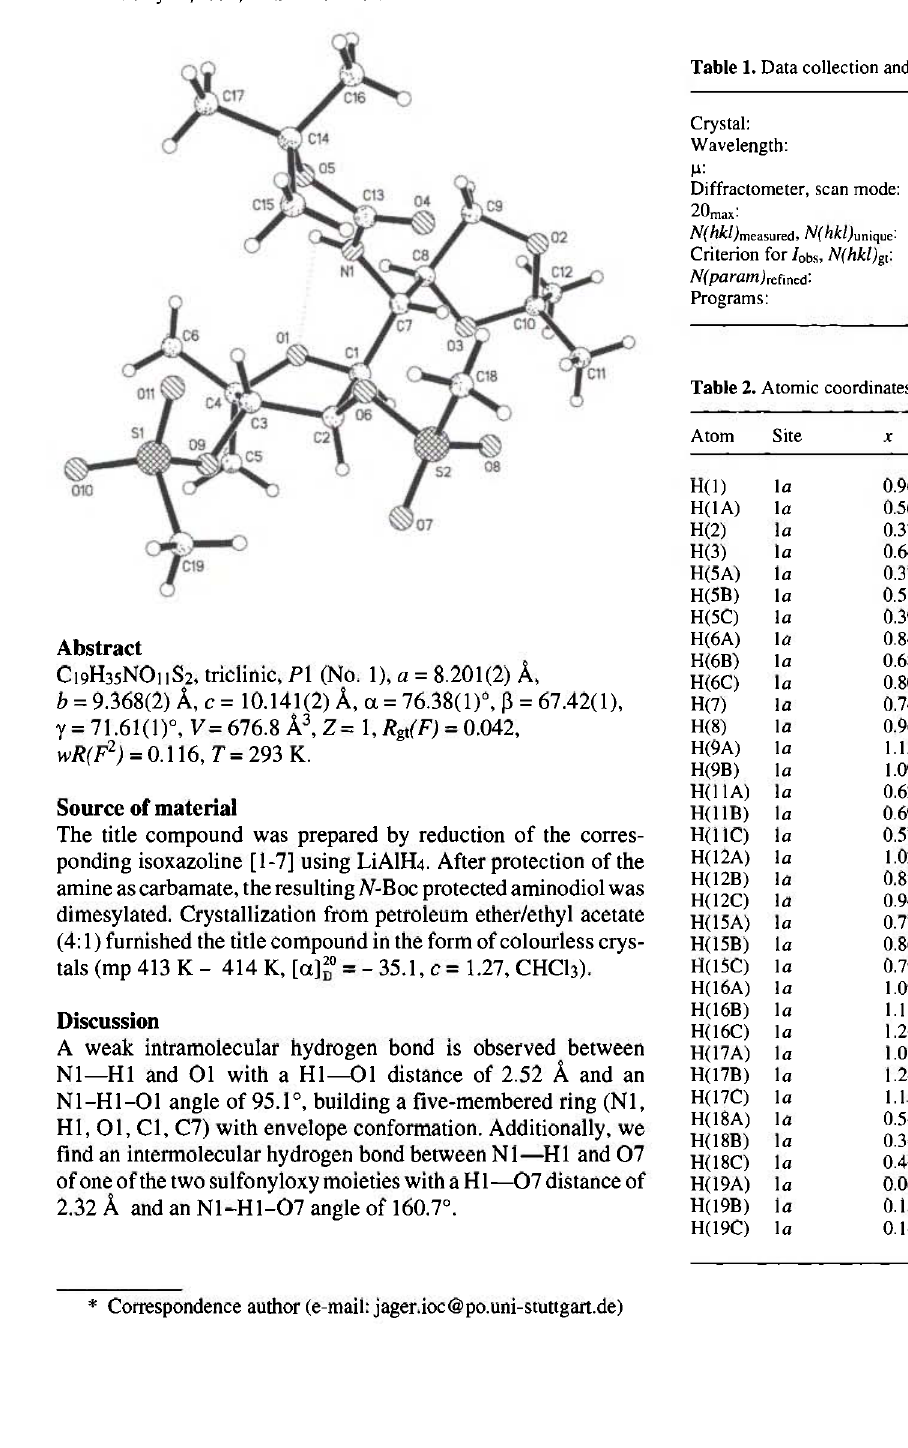
Table 1. Data collection and handling. Crystal: